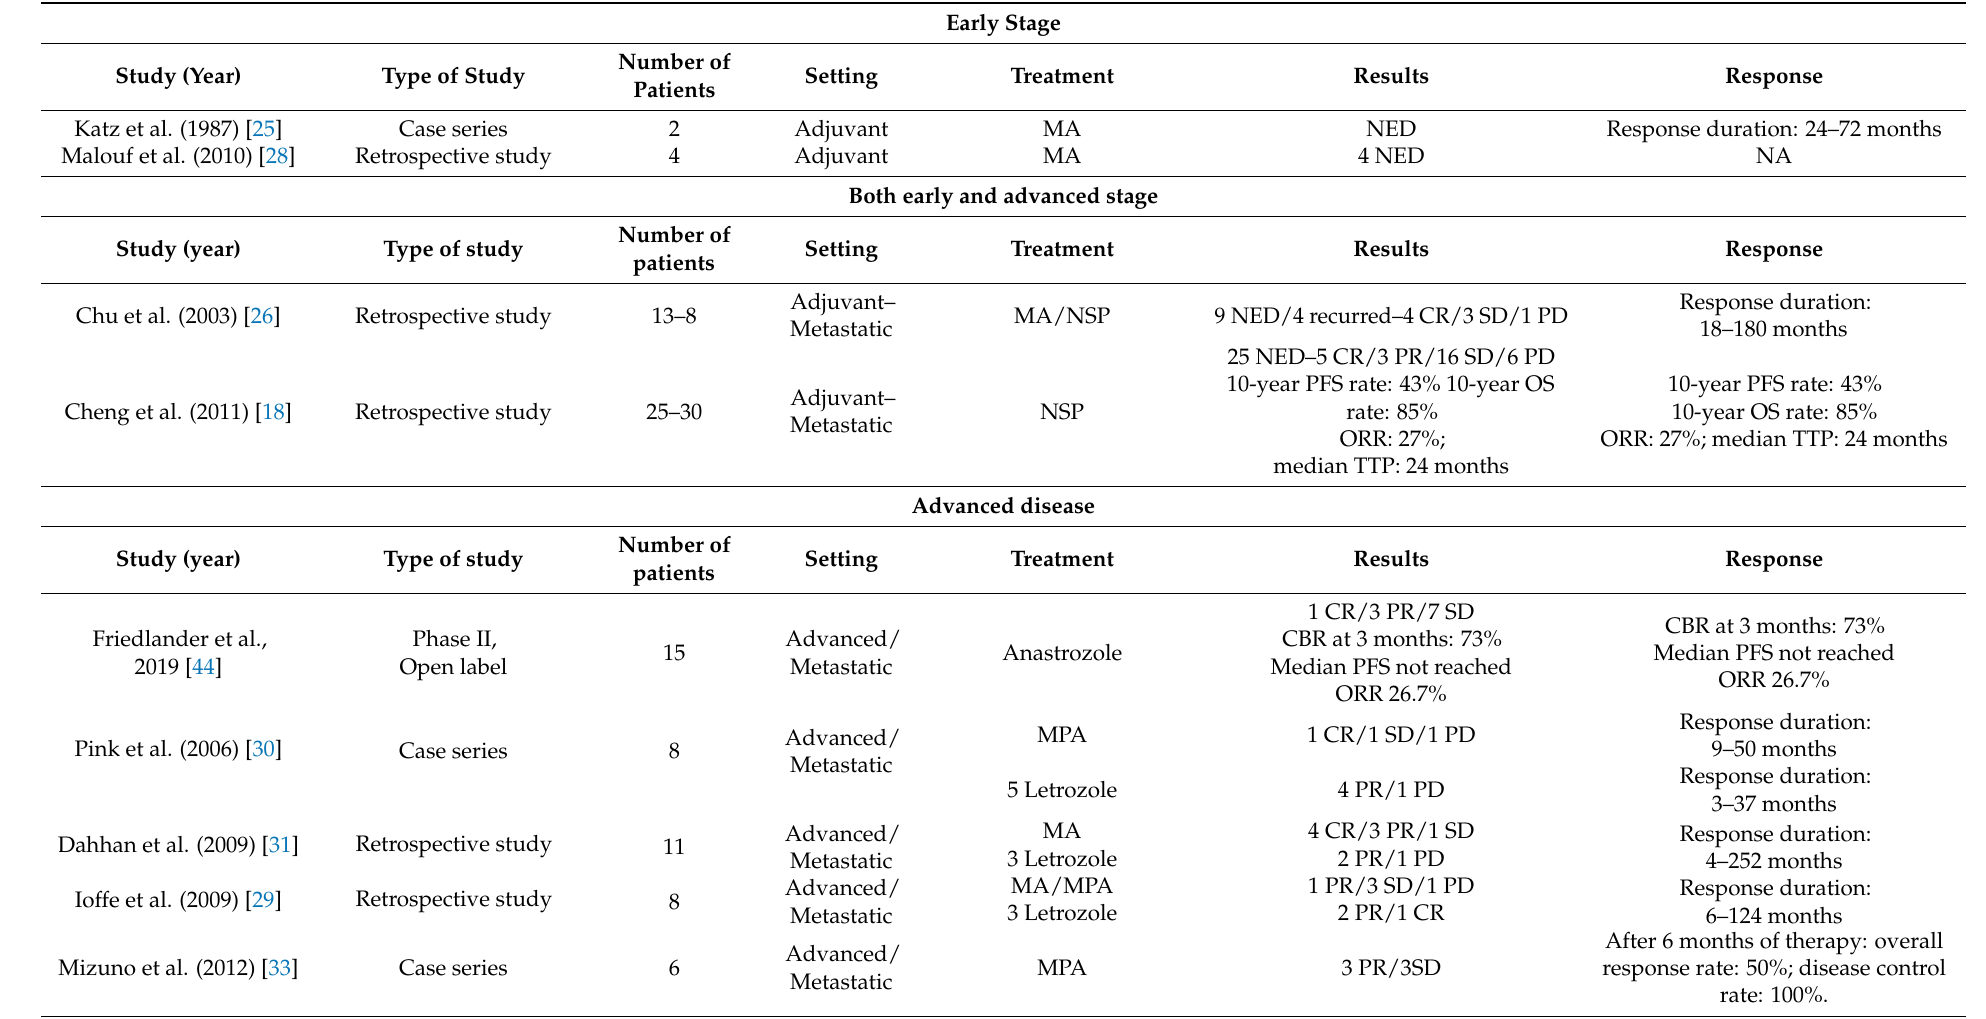
Table 1. Summary of data upon hormonal therapy used for the treatment of